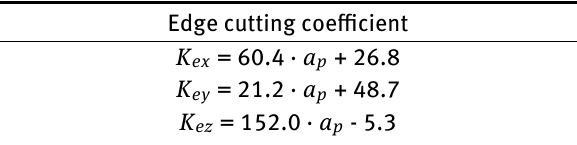
Table 2: Edge cutting coeflcient functions. Dependence on the depth of cut.